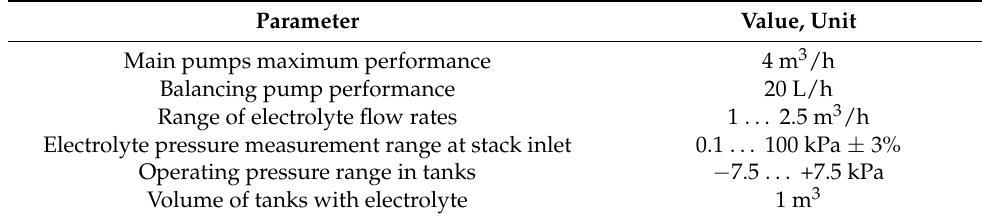
Figure 3. Hydrodynamic scheme of the VRB test bench: 1—VRB stack; 2—tanks with elec- trolyte; 3—main pumps for pumping electrolyte; 4—balancing pump; 5—electrolyte flow sensors; 6—pressure sensors; 7—outlet pipes; 8—branch pipes with an outlet in the form of a fitting; 9—branch pipes with pressure relief valves. Table 3. 30 kWh test bench characteristics.